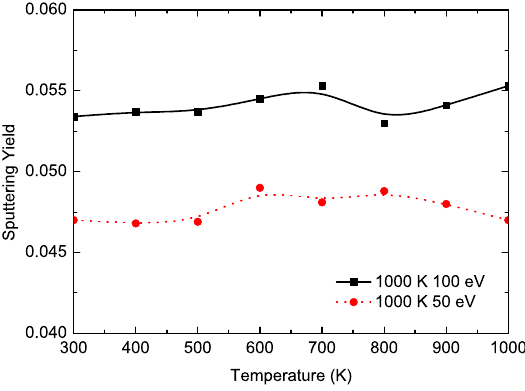
Figure 5. Sputtering yield of SiC bulk with 62 at % C concentration as a function of its